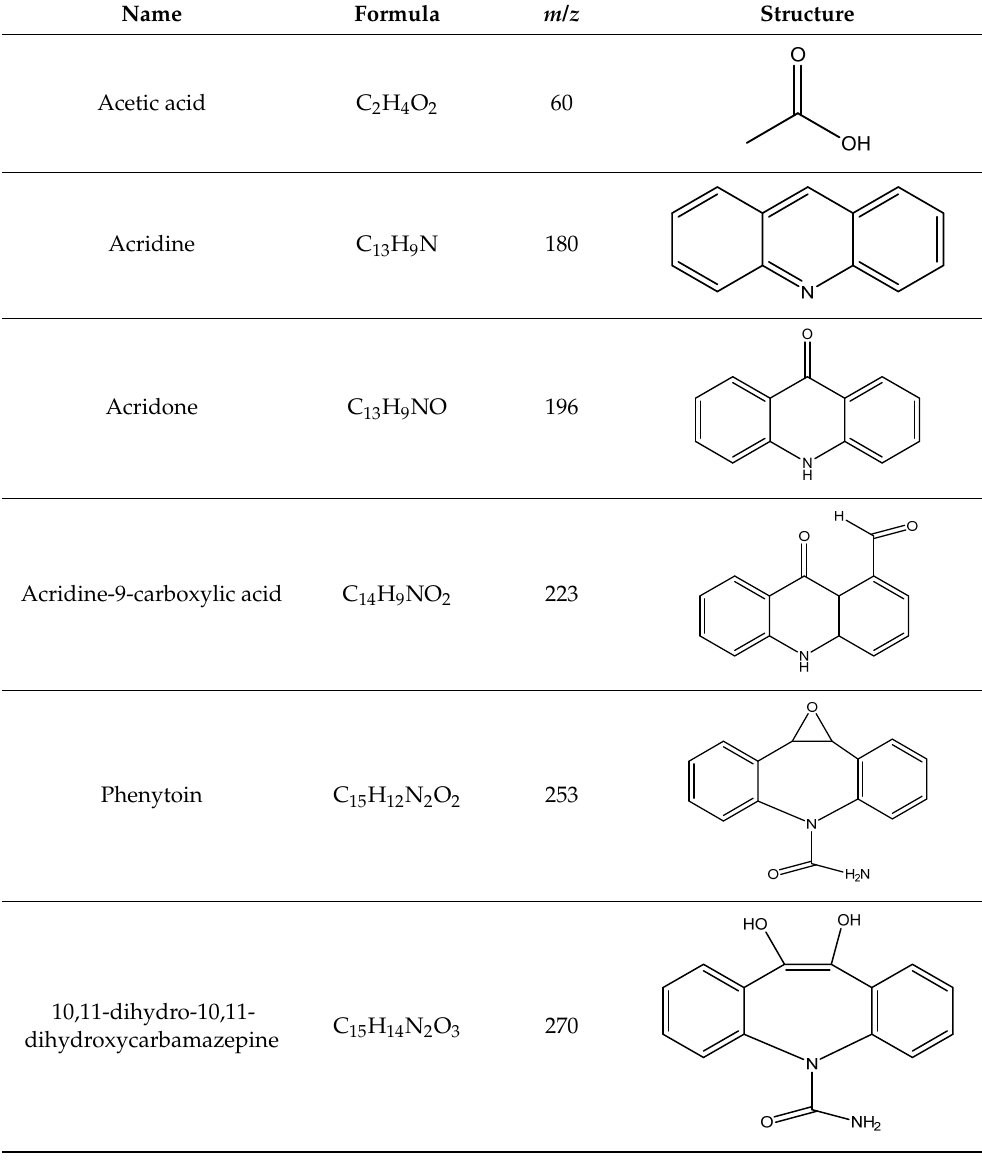
Table 2. Identification of by-products in the photodegradation of CBZ. Table 2. Identi fi cation of by-products in the photodegradation of CBZ. Table 2. Identi fi cation of by-products in the photodegradation of CBZ. Table 2. Identi fi cation of by-products in the photodegradation of CBZ. Table 2. Identi fi cation of by-products in the photodegradation of CBZ. Table 2. Identi fi cation of by-products in the photodegradation of CBZ. Table 2. Identi fi cation of by-products in the photodegradation of